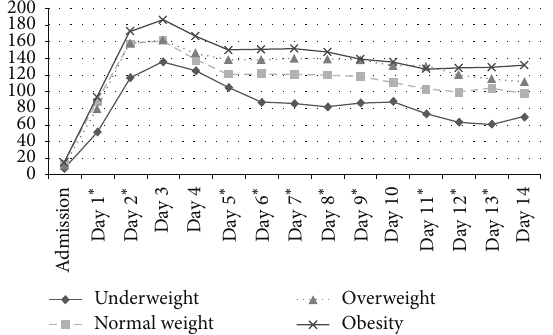
Figure 2: Mean CRP courses (mg/L) evaluated from admission to day 14 according to the BMI groups. Significant differences (𝑃 < 0.05) are marked with an asterisk referring to the day of